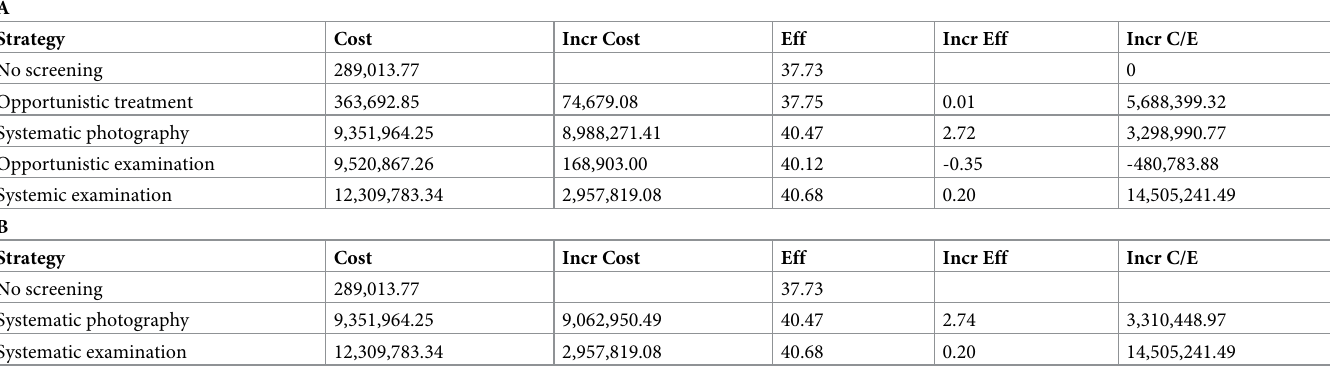
Table 2. Cost-effectiveness of intervention strategies for AMD screening (A) all strategies (top) and (B) excluding dominated strategies